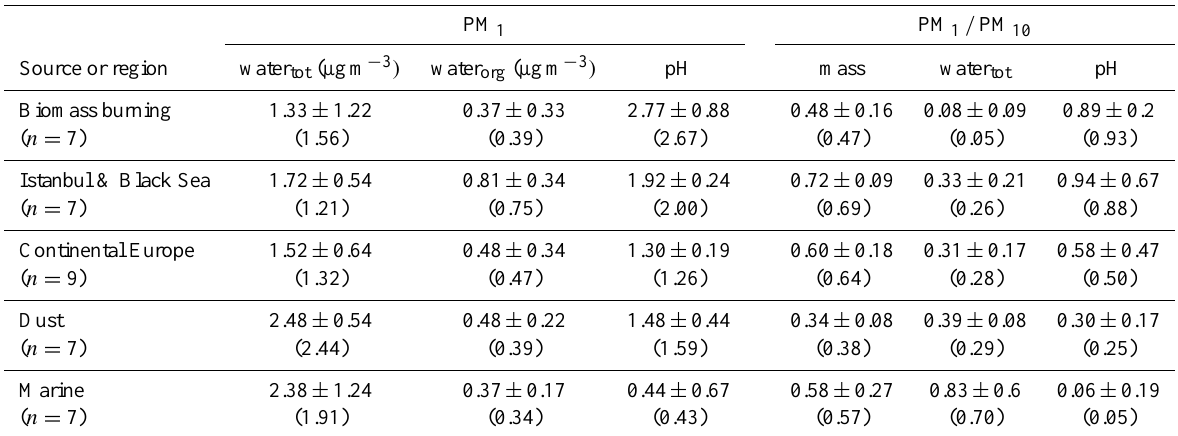
Figure 5. Diurnal profile of pH (a) and H + (b) calculated based on total predicted water and hydronium concentrations predicted by ISORROPIA-II. Average and median (with 25 and 75% quantiles) values are provided. Table 1. Average values of water content (total and organic) and pH with standard deviation and median values in